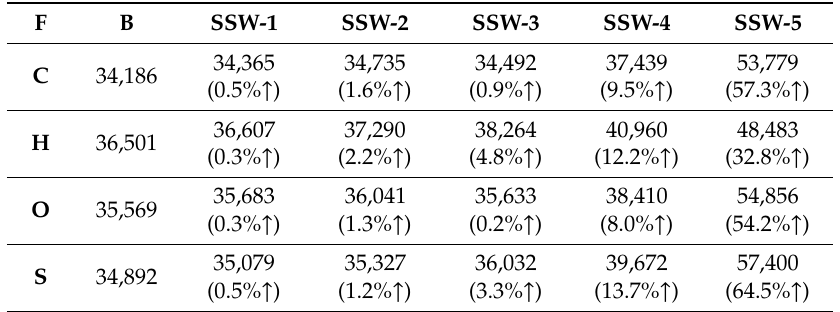
Table A5. Travel distance for residents in Taipa Parish to